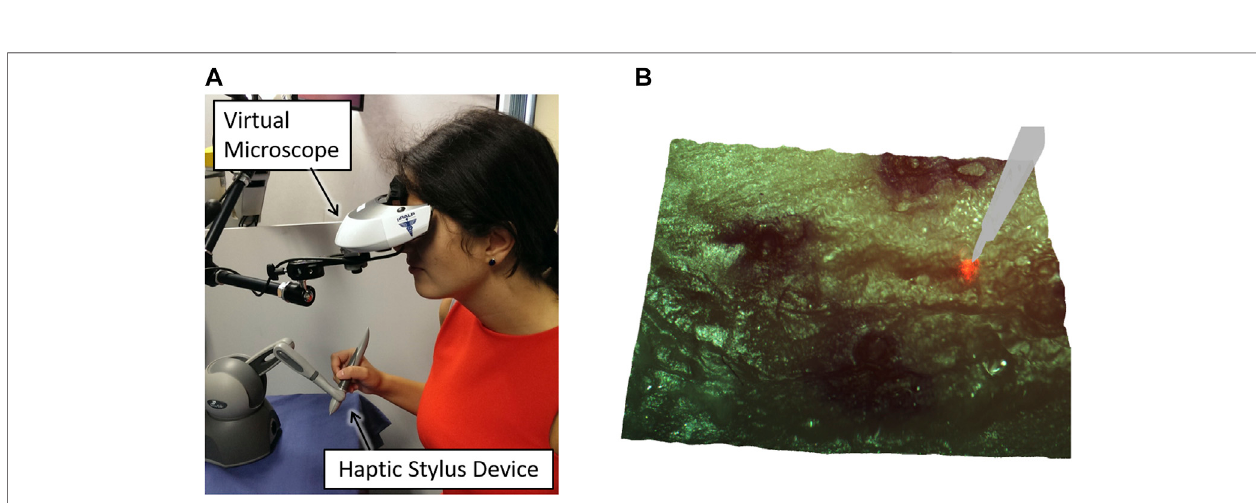
FIGURE 11 | The Haptic Laser Scalpel, developed to bring the sense of haptics to contactless laser surgeries (Olivieri et al., 2018). (A) Surgeon interface (B) 3D visualization of the surgical site with a virtual haptic scalpel avatar.